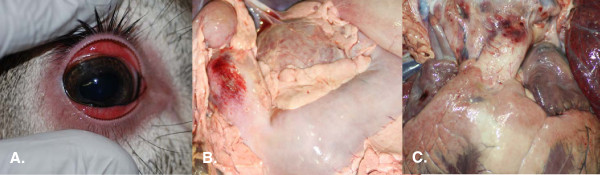
Clinical outcome of a white-tailed deer infected with EHDV-7 by the bite of C. sonorensis. A) Photograph taken on 9 dpf just prior to euthanasia showing prominent erythema of periorbital skin and severe congestion and edema of the conjunctiva. B) Paintbrush hemorrhage in the wall of the abomasum at the level of the pylorus. C) Subintimal hemorrhage at the base of the pulmonary artery. [Both B) and C) are considered classic lesions of acute hemorrhagic disease in WTD.].